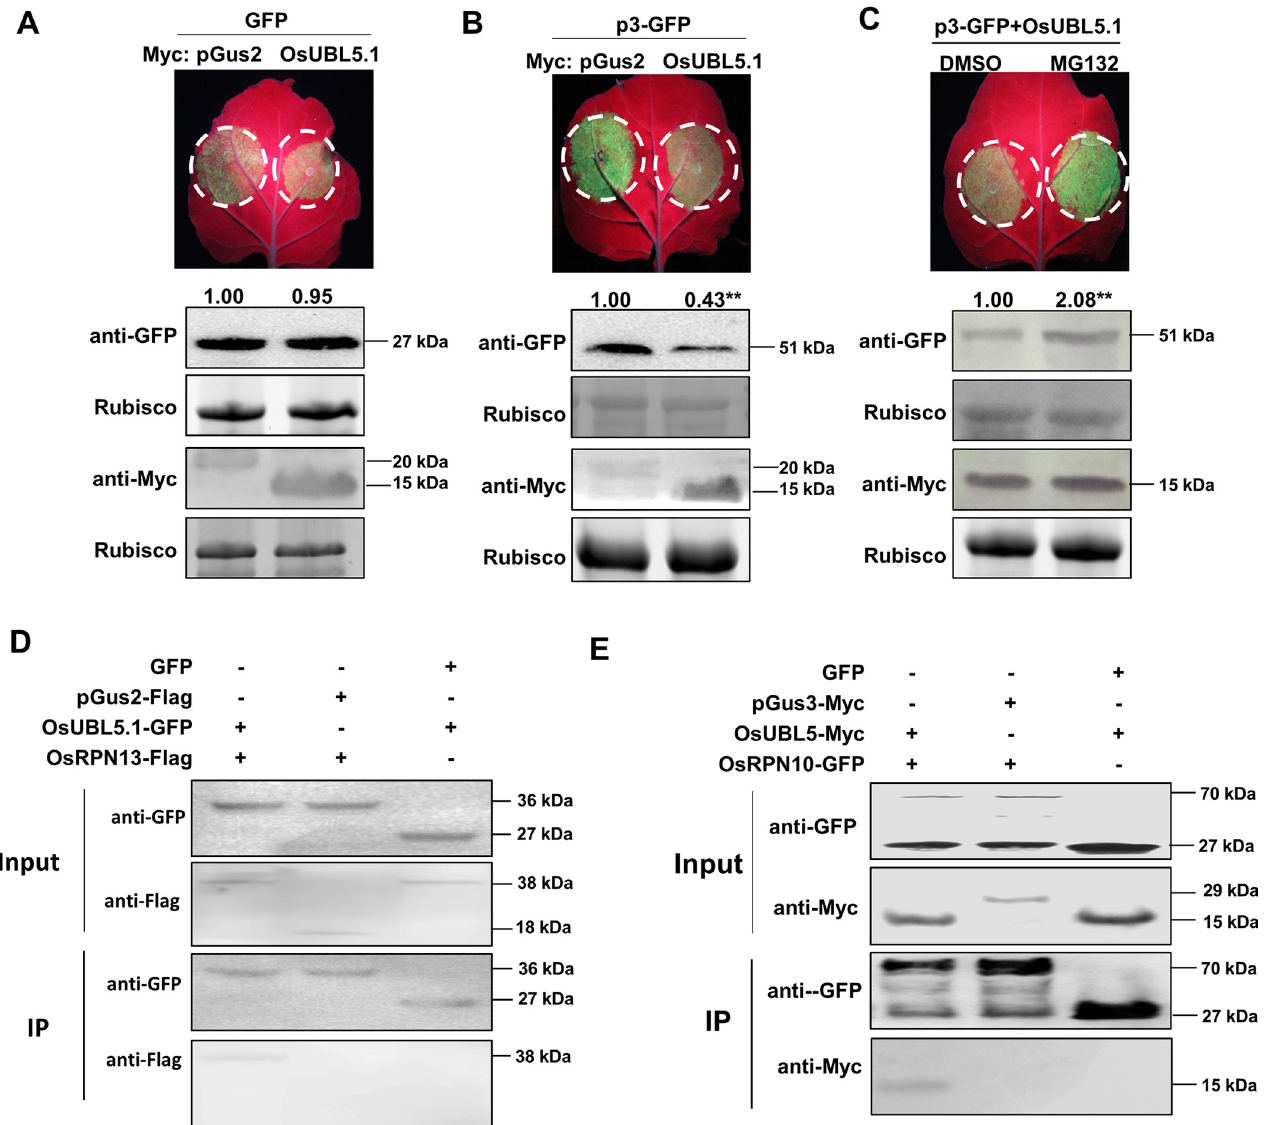
Fig 6. OsUBL5.1 mediates p3 degradation through tbe 26S proteasome system and interacts with OsRPN10 and OsRPN13 from O . sativa . A. Myc-fused OsUBL5 had no effect on GFP expression on leaves when it was co-expressed with GFP by agroinfiltration. B. Myc-fused OsUBL5 reduced GFP-fused p3 protein accumulation when they were co-expressed. C. Reduction of GFP-fused p3 protein caused by Myc-fused OsUBL5 was inhibited by MG132 treatment. Myc-fused pGus2 was used as control. GFP and Myc-fused proteins were detected by western blot. D and E. Co-IP showed the interaction of OsUBL5 with OsRPN13 and OsRPN10, respectively. Myc-fused pGus3 was used as control. Results are from three biological replicates. Band intensity in blots was calculated by ImageJ based on three replicates. A two-sample unequal variance directional t test was used to test the significance of the difference ( �� , p value < 0.01).